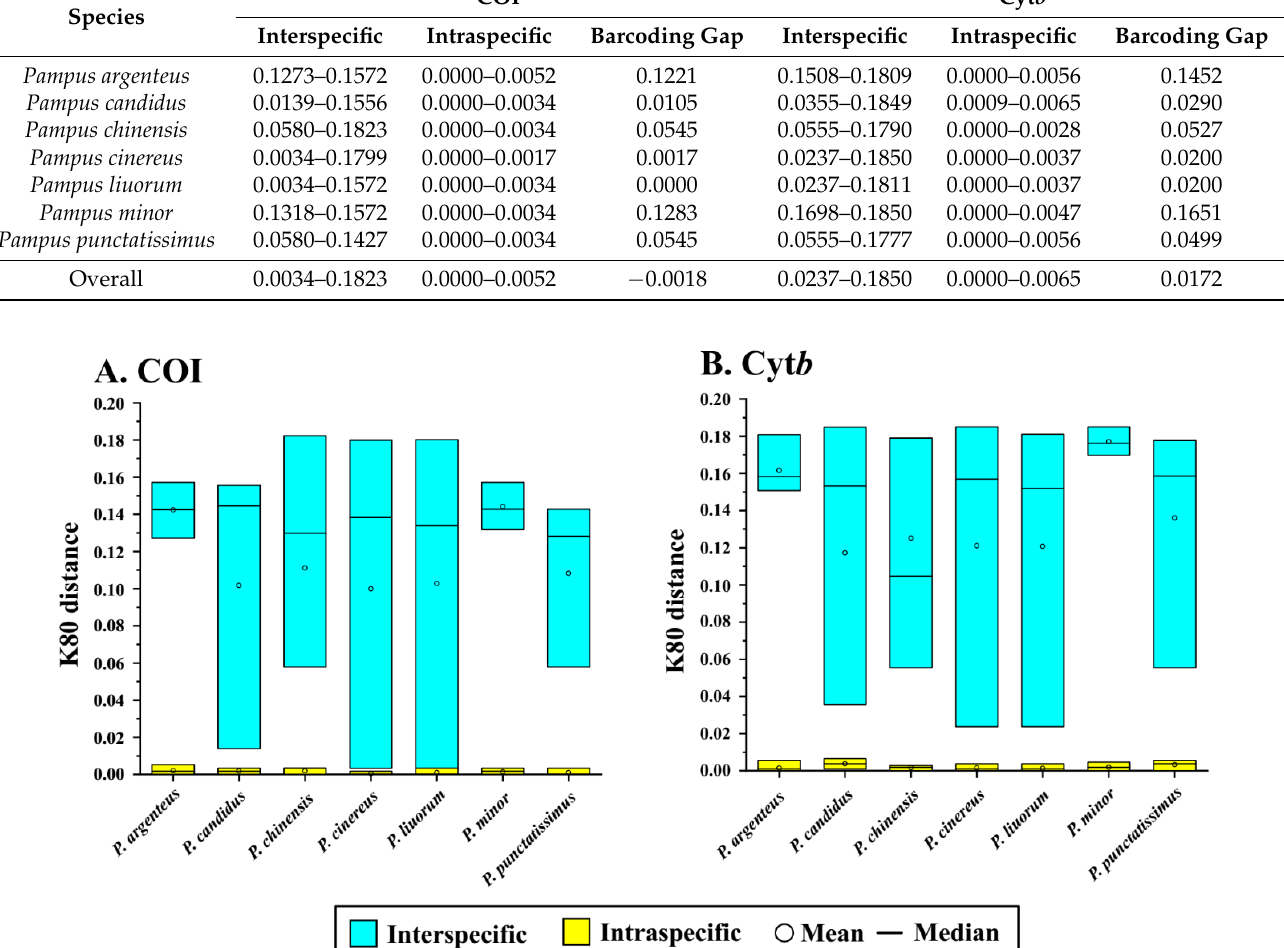
Table 2. Interspecific and intraspecific K2P distances of the seven analyzed Pampus species.